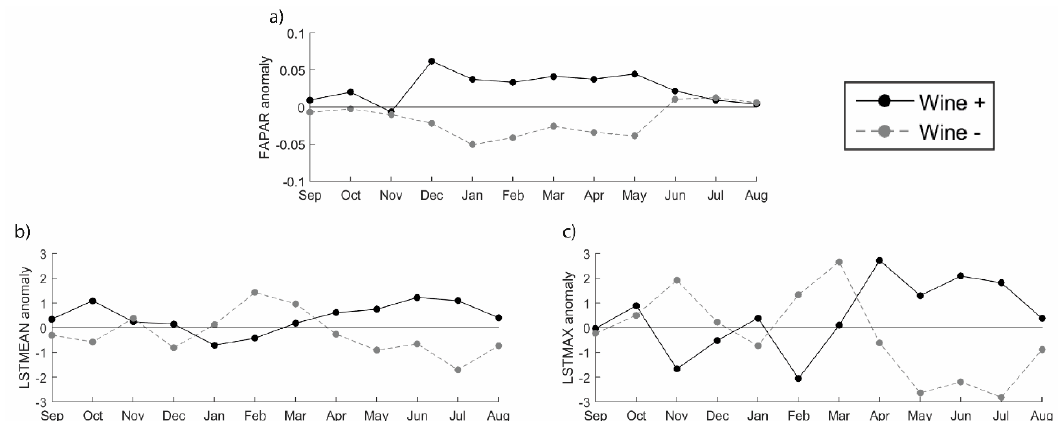
Figure 5. Annual cycles of monthly composites of anomalies for the selected predictors in the modelling process of the PDO wine production for the DDR: ( a ) FAPAR; ( b ) LST MEAN and ( c ) LST MAX. Wine + ( − ) class represents the anomalies associated with PDO wine production years above the 3rd quartile (below the 1st quartile).